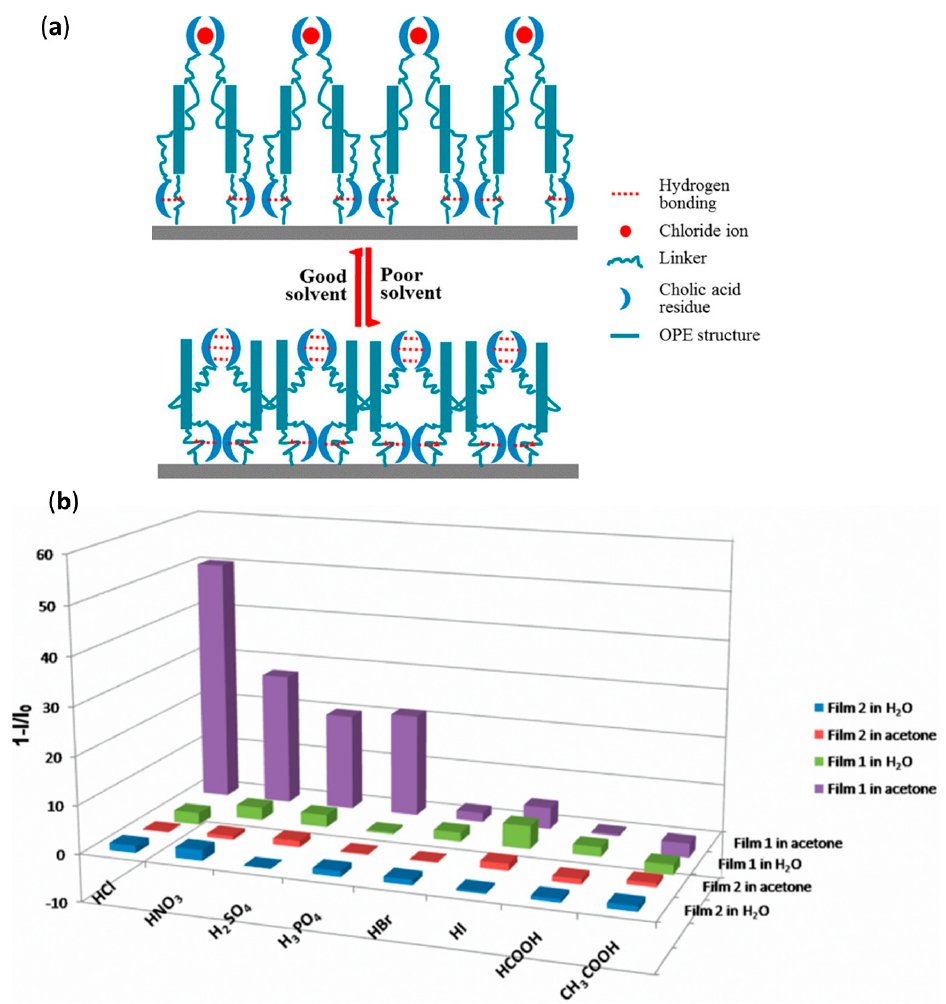
Figure 10. ( a ) Illustration of immobilized oligomer (Table 1, no. 42) conformations in different medium representing good (acetone as an example) or poor solvent (water, for example). In a good solvent, the hydrophilic pocket is formed as an upper layer of the film. ( b ) Quenching efficiencies of various acids to the fluorescence emission of Film 1-oligo(p-phenylene ethynylene) with cholic acid side chains (Table 1, no. 42) and Film 2-oligo(p-phenylene ethynylene) (Table 1, no. 41) in water and acetone, respectively (concentration of acids are 20 μ M). Reprinted with permission from [85] . Copyright 2012 American Chemical